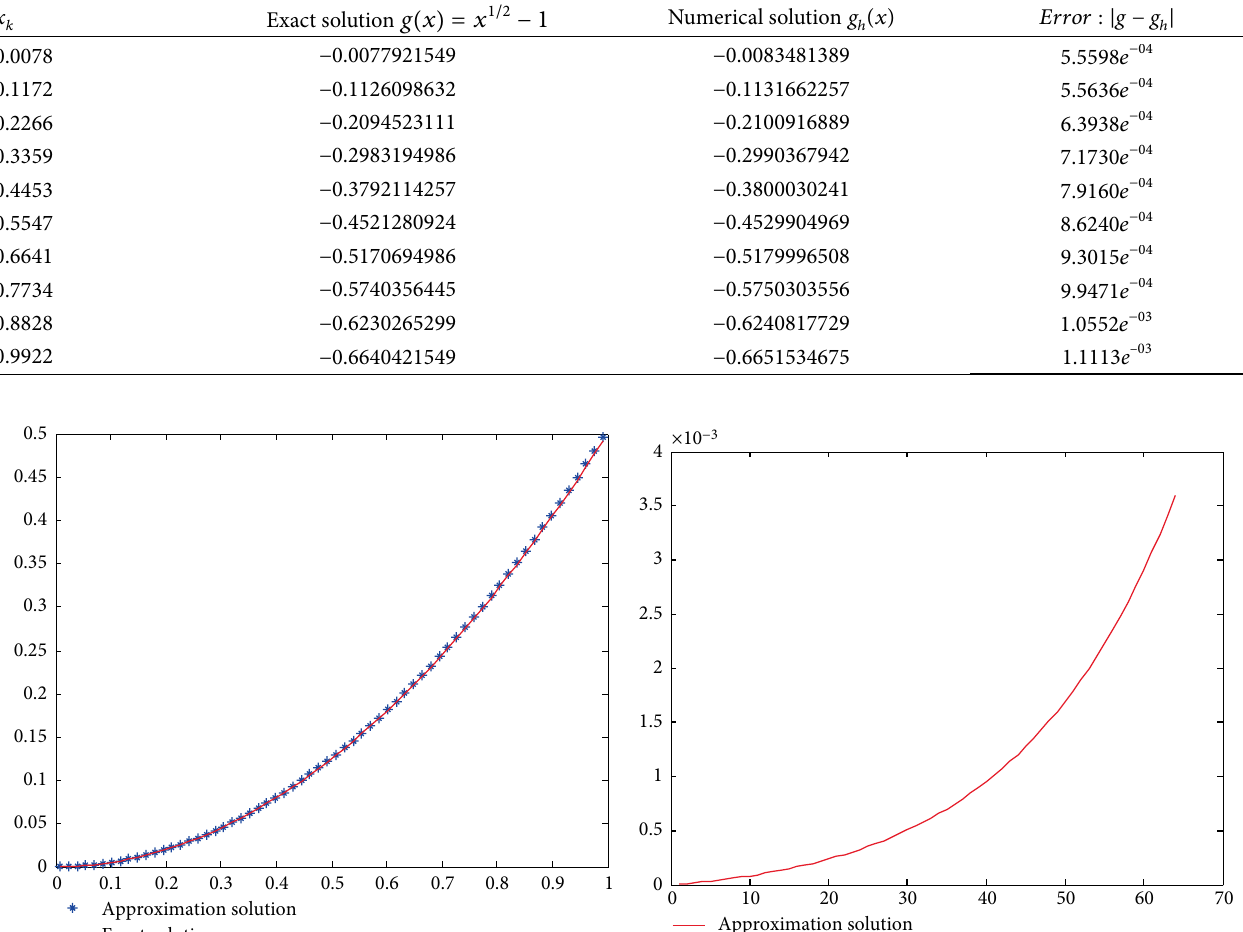
Table 4: The exact and numerical solutions using the Haar wavelet method with 𝑁 = 64 .